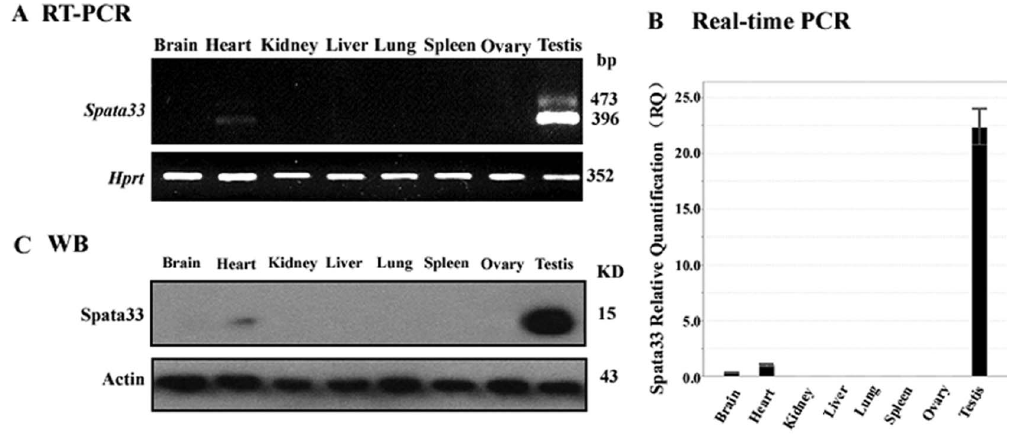
Figure 3. Expression pattern of Spata33 in various tissues of adult mouse. A). RT-PCR of Spata33 in adult tissues. Hprt was used as a standard. The gene Spata33 was predominantly expressed in testis. Molecular weight is shown on the right. B). Real-time fluorescent quantitative PCR of the Spata33 gene in adult tissues. Error bars indicate the standard deviation (SD) of the mean (n=3). Y-axis represents relative expression levels of Spata33 and X-axis shows different mouse tissues. C). Expression of Spata33 protein in various tissues. Mouse tissues were subjected to Western blot analysis with antibody against Spata33. Spata33 protein recognized a band at 15 KD. The Spata33 protein was predominantly expressed in testis. Actin was used as an internal control. Molecular weight is shown on the right. We repeated each experiment three times with independent